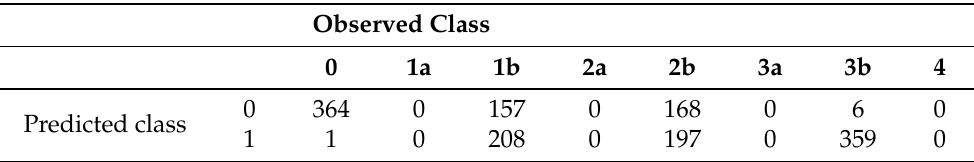
Table 8. Detailed confusion matrix for the SVM model and the two-class classification. All anomalous samples are separated into the original